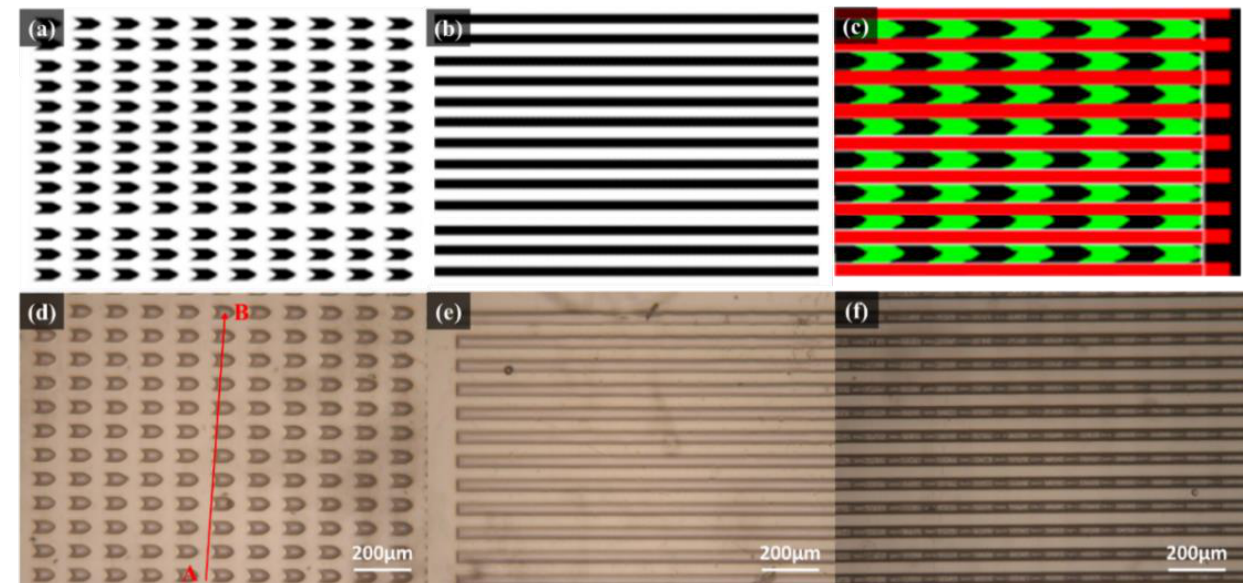
Figure 4. Diagram of ( a ) the first and ( b ) the second layers of photomask patterns; ( c ) overlaid photomask patterns. Optical microscope (OM) image of ( d ) first layer pattern, ( e ) second layer pattern, and ( f ) overlaid layers pattern of SU-8 photoresist. The line point A to point B passes through the plane and the pattern indicates the segmented plane of the cross-section from the first layer of SU-8 photoresist.